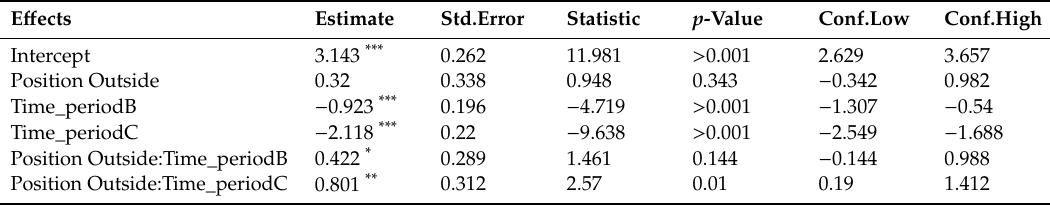
Table 2. Estimated regression parameters (log), standard errors, z-values, and p -values for the negative binomial GLMM of S. titanus counts with covariates Trap position and Time period and their interaction. The lasts two columns define lower and upper limits for 95% confidence interval. The estimated value for σ Vineyard is 0.334 and σ Trap is 1.007.